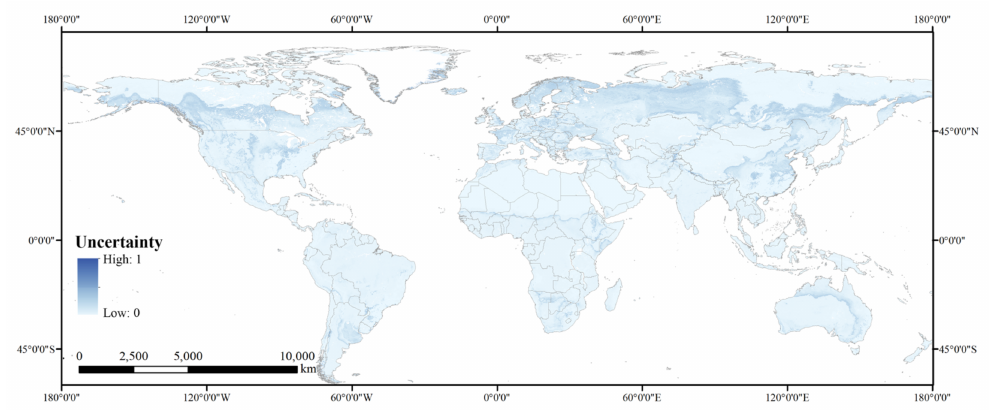
Figure 3. Visualized uncertainty in spatial prediction using standard deviation values calculated for each pixel across the model